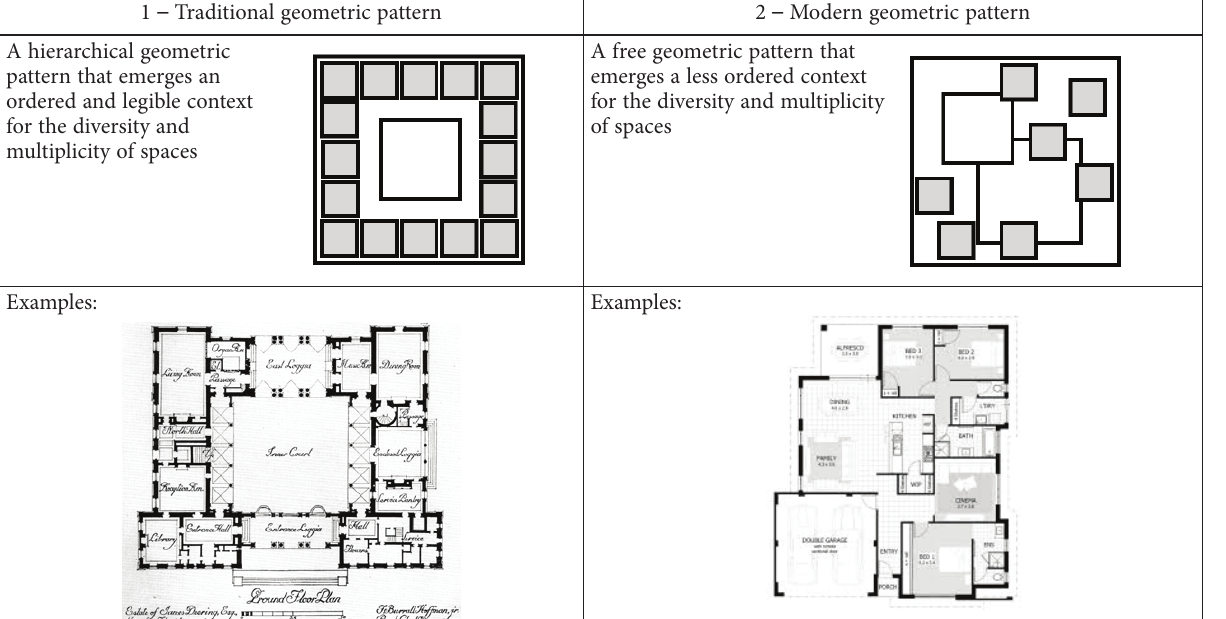
for the diversity and multiplicity of